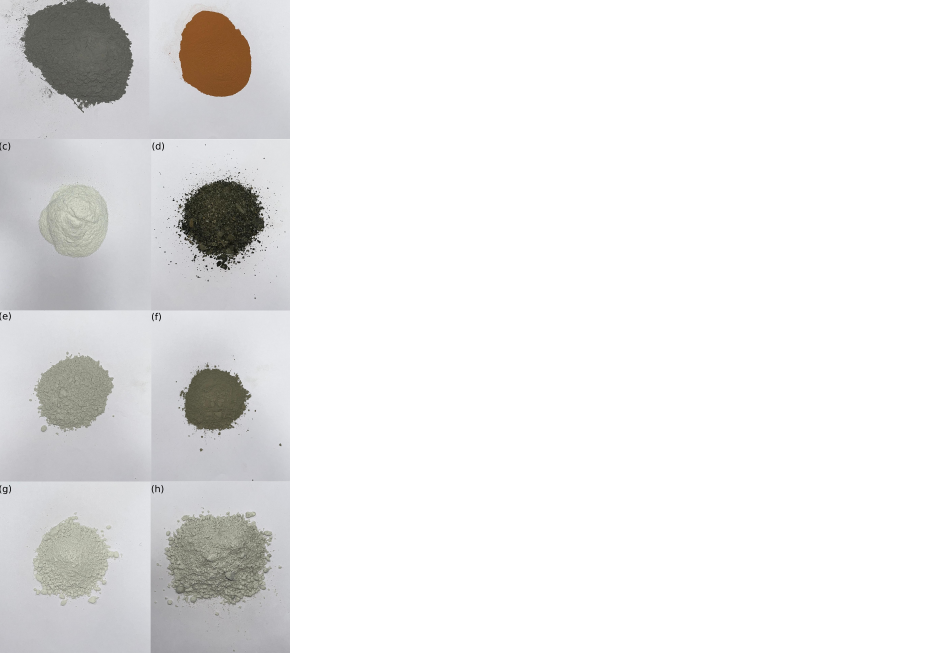
Figure 2. RHA ( a ), BD ( b ), MD ( c ), SD ( d ), FA ( e ), OPC ( f ), LD ( g ), and SF ( h ) filler